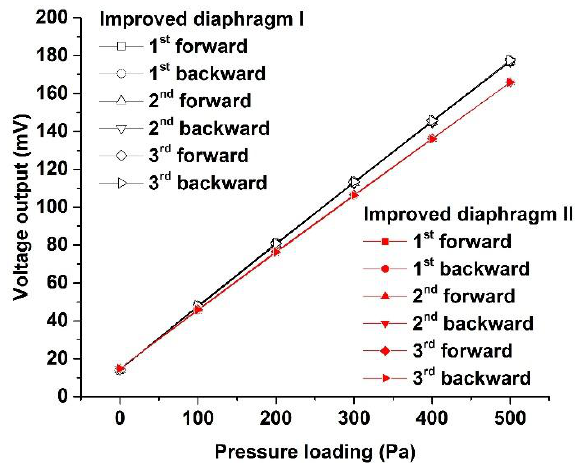
Figure 27. Output voltage versus applied pressure with a range from 0 to 500 Pa.